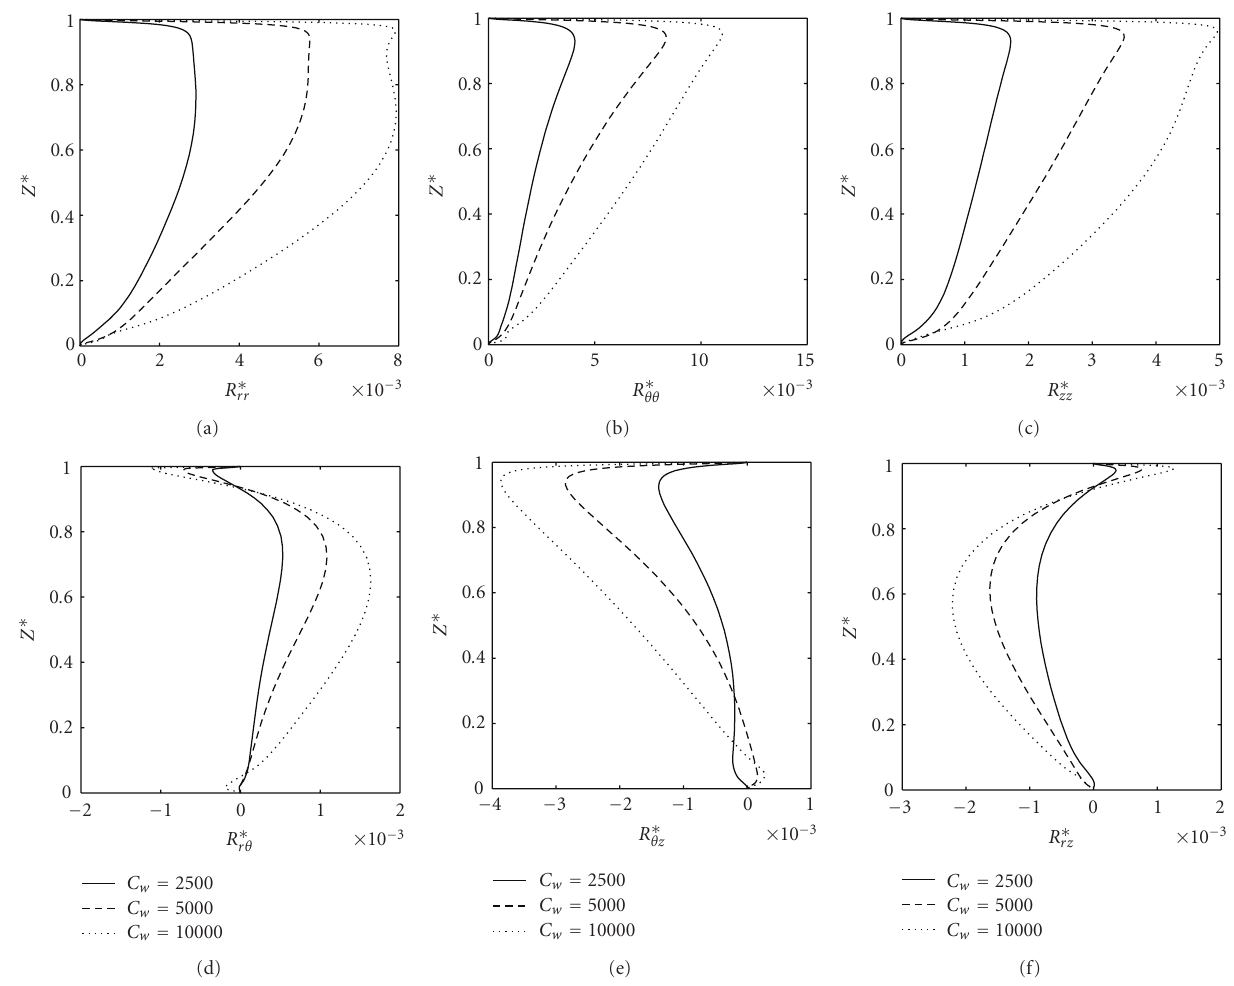
Figure 26: Axial profiles of the six Reynolds stress tensor components for Re = 10 6 , G = 0 . 02 at r ∗ = 0 . 57 and three flowrate coe ffi cients C w >